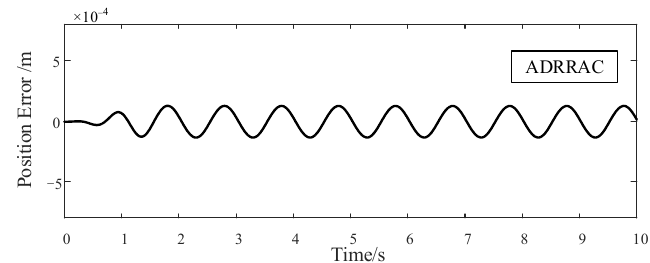
Figure 10. ADRRAC Tracking Error of 1 Hz Sinusoidal Signal.